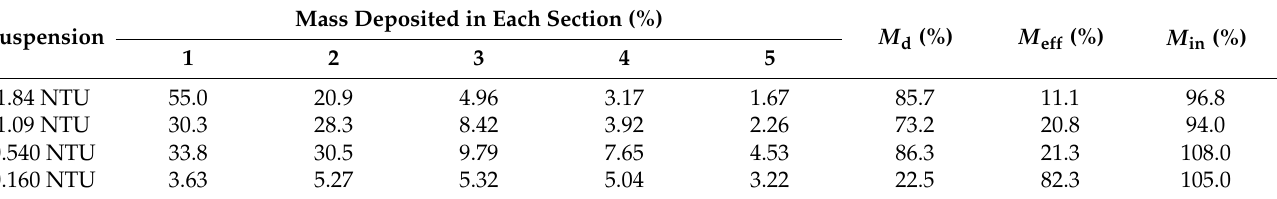
Table 1. Spatial mass distribution of differently sized particles in the columns (or mass balances), including mass percentages retrieved in the effluent ( M eff ), deposition in each of the five column sections as a whole ( M d ), and injection mass ( M in = M eff + M d